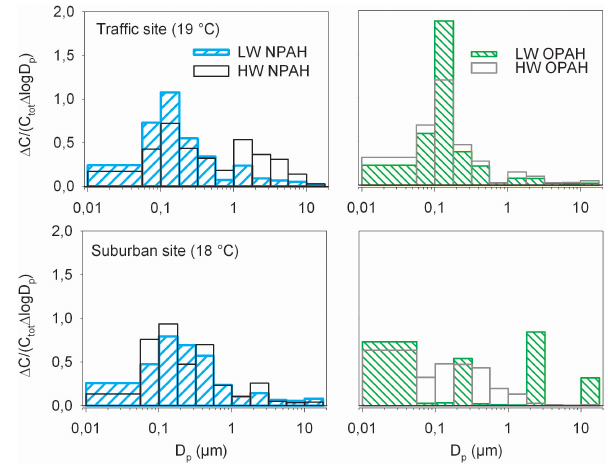
Fig. 3. Particle size distributions at traffic and suburban sites of 6 . NPAHs and 6 . OPAHs according to their molec- ular weight range (LWNPAHs: MW ≤ 223gmol − 1 ; HWN- PAHs: MW ≥ 247gmol − 1 and LWOPAHs: MW ≤ 208gmol − 1 ; HWOPAHs: MW ≥ 230gmol − 1